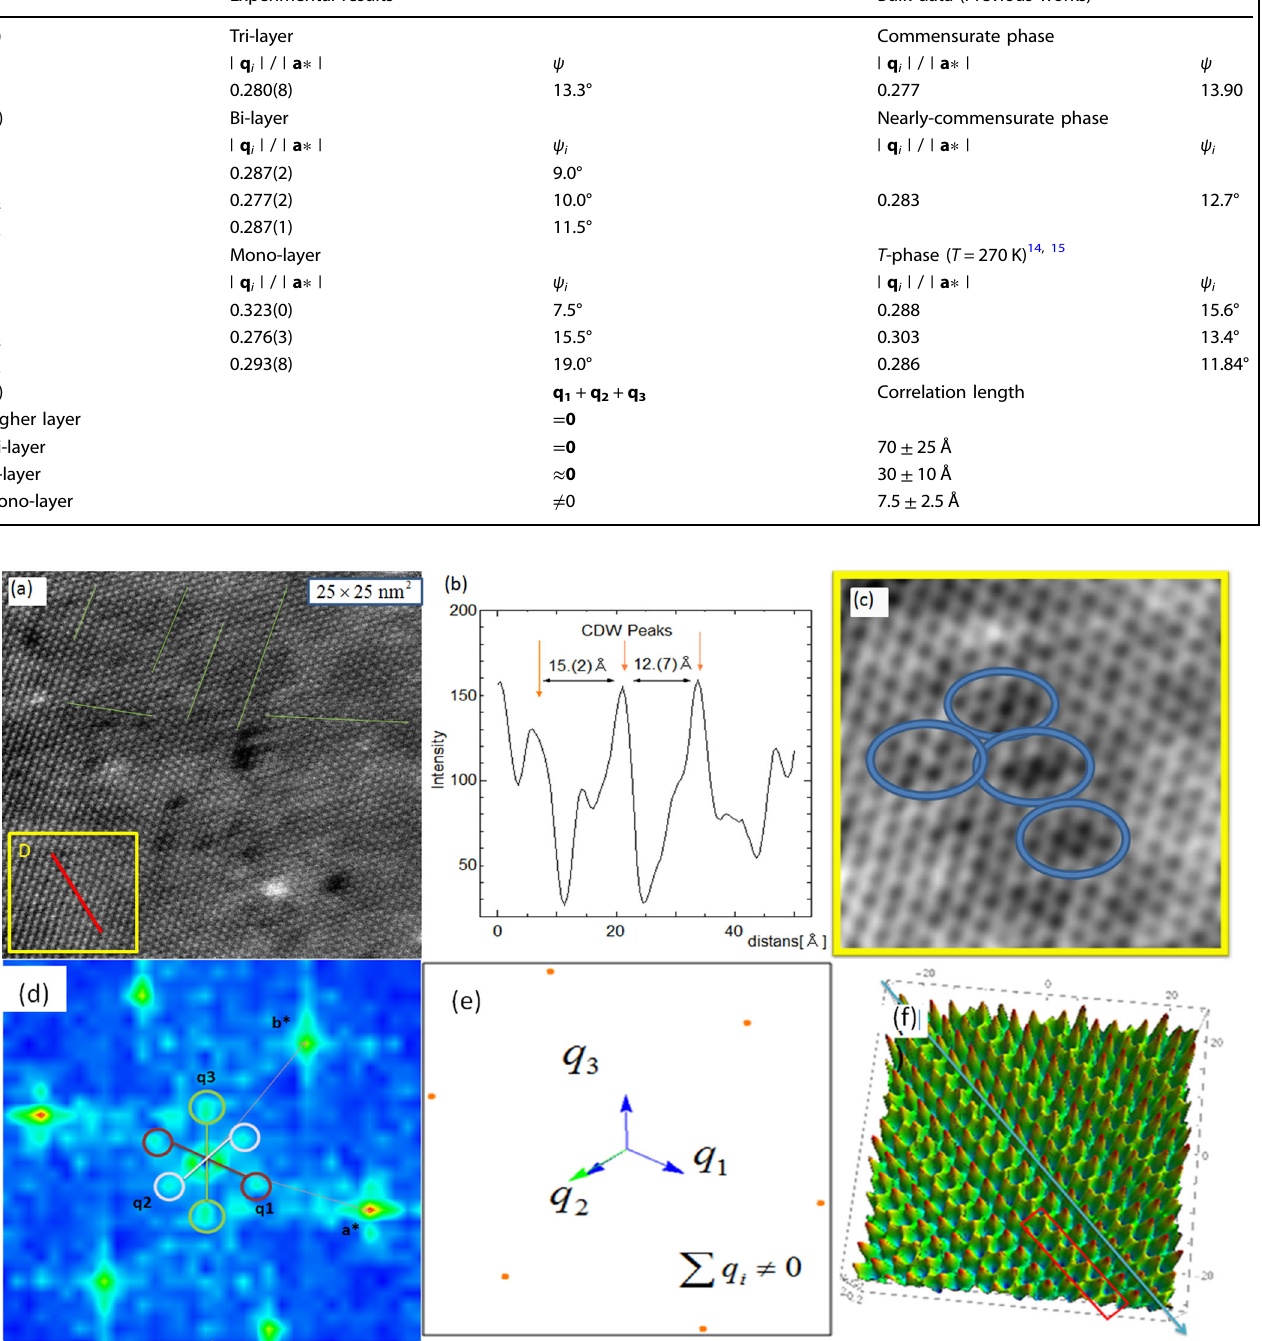
Table 1. (a) Parameters of q vectors for the Bi-layer sample: Two of the q vector lengths are the same. This is a feature of the stripe phase. The magnitude of the q vectors is shown due to the three-fold symmetry. (b) Parameters of q vectors for the mono-layer sample. Only the q 2 value of the Nearly commensurate phase is shown due to the three-fold symmetry. (c) It is con fi rmed that the lattice symmetry is maintained. The symmetry of triple q is clearly broken. Correlation lengths were estimated by auto-correlation analysis Experimental results